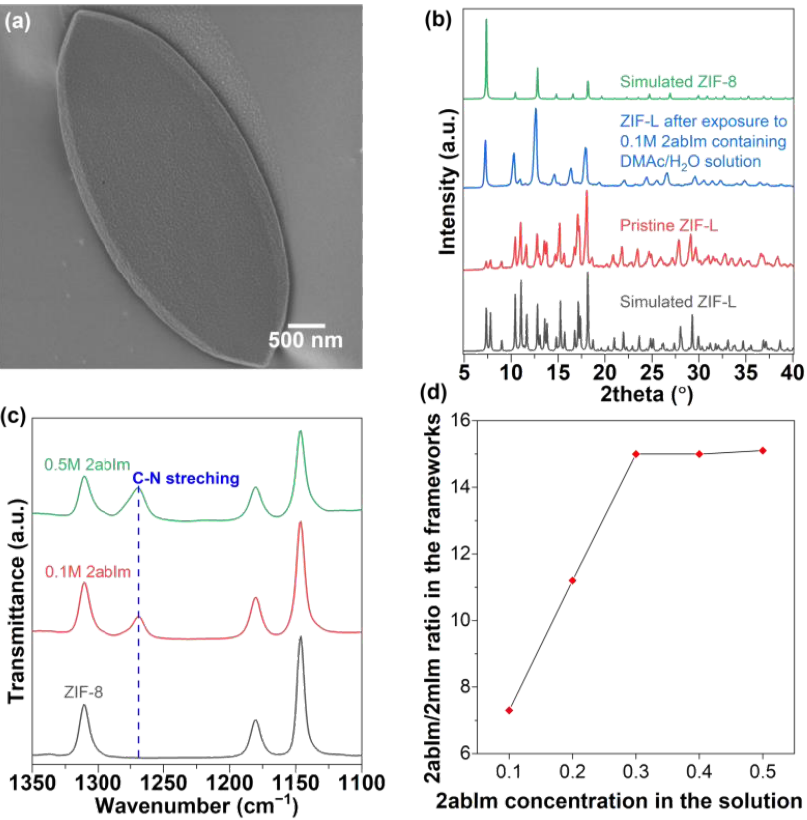
Figure 4. ( a ) SEM image of ZIF-L upon exposure to 0.1 M 2abIm containing 2:1 ( v / v ) DMAc/H 2 O solution for 8 h at 373 K, ( b ) XRD patterns of ZIF-L before and after exposure to 0.1 M 2abIm containing 2:1 ( v / v ) DMAc/H 2 O solution for 8 h at 373 K, ( c ) ATR-FTIR on 0.1 M, and 0.5 M of 2abIm treated ZIF-8 crystals, ( d ) composition analysis curves of 2abIm-treated ZIF-8 crystals obtained by solution 1 H-NMR.